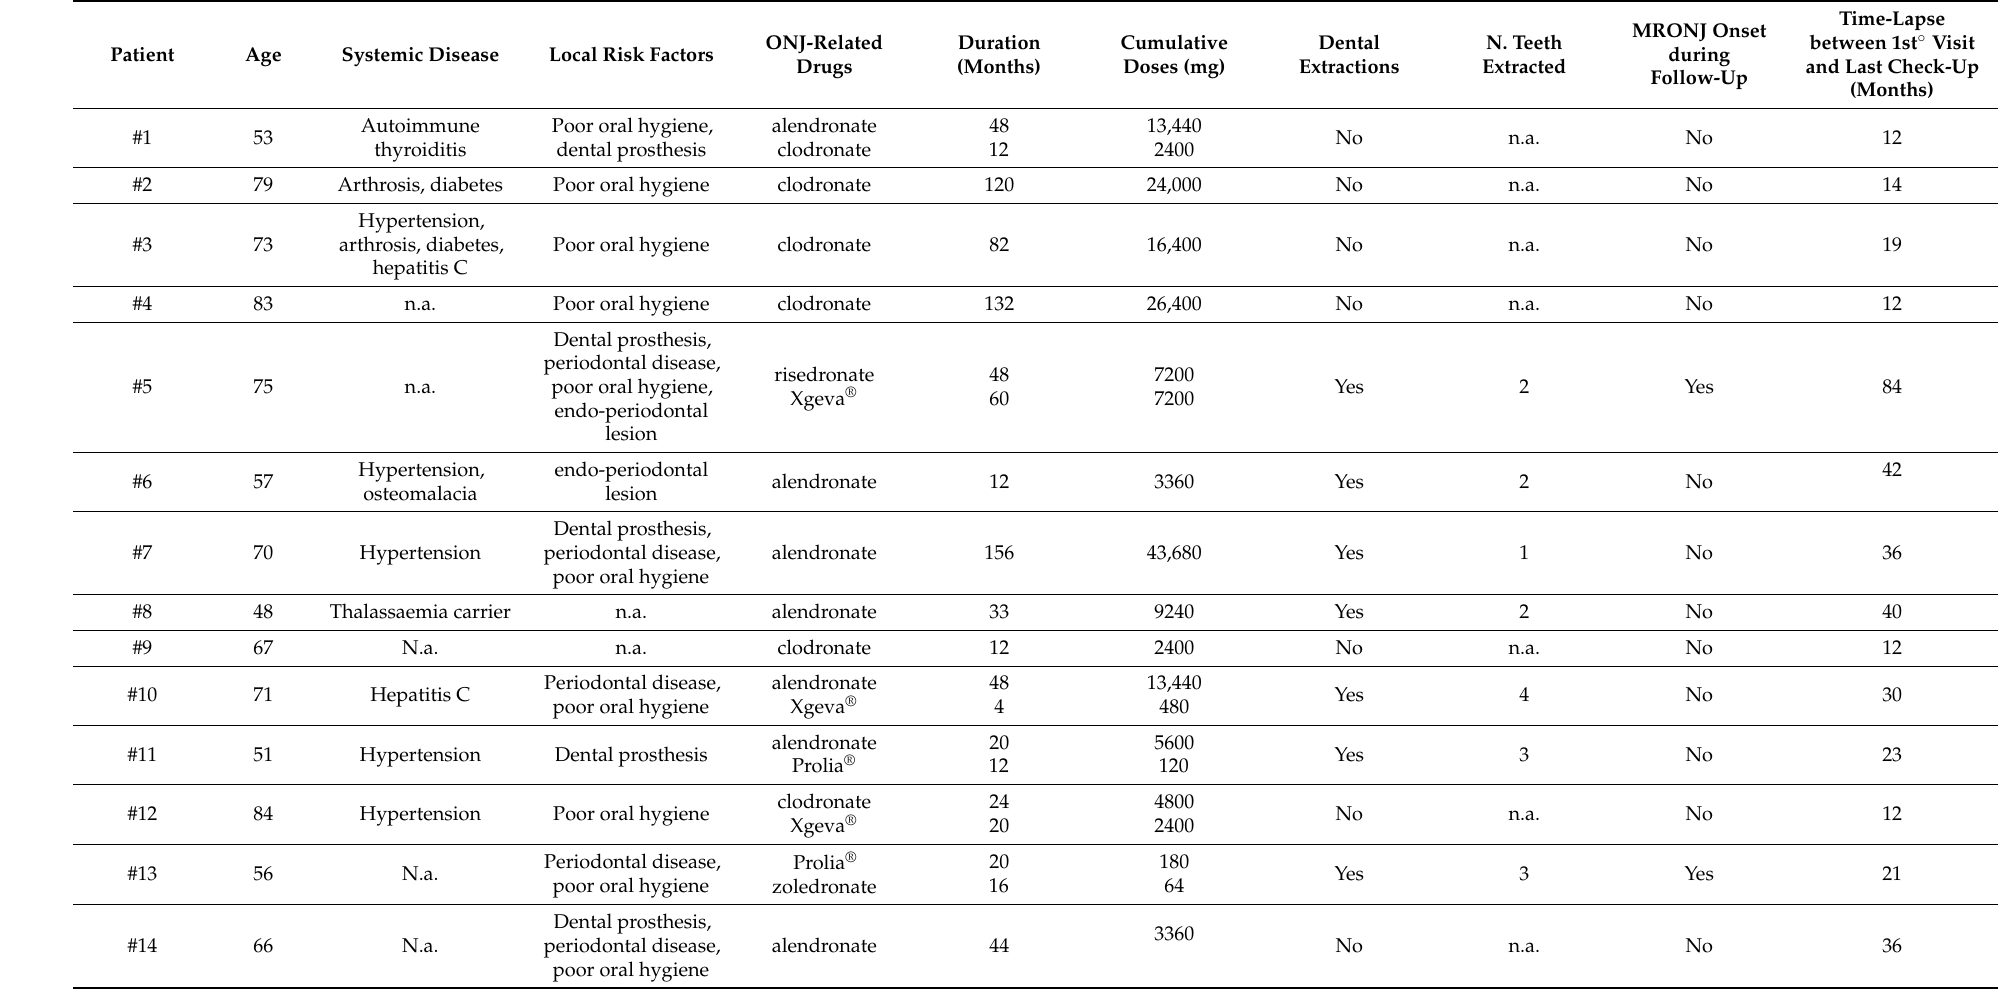
Table 1. Characteristics of enrolled breast cancer